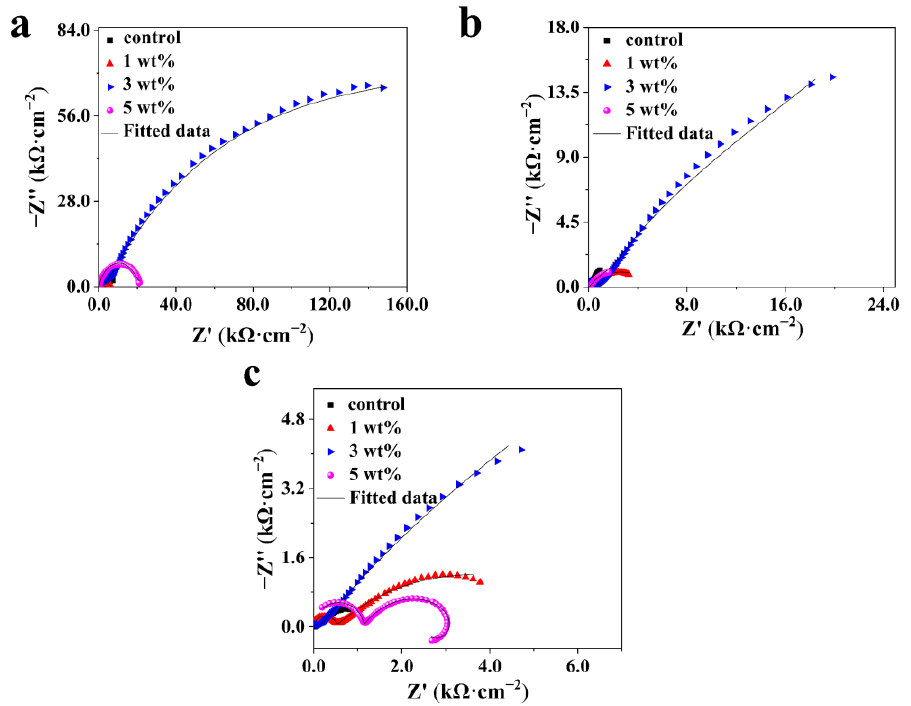
Figure 10. Nyquist plots of different coatings immersed in 3.5 wt% NaCl solution for ( a ) 48 h, ( b ) 144 h, and ( c ) 840 h.